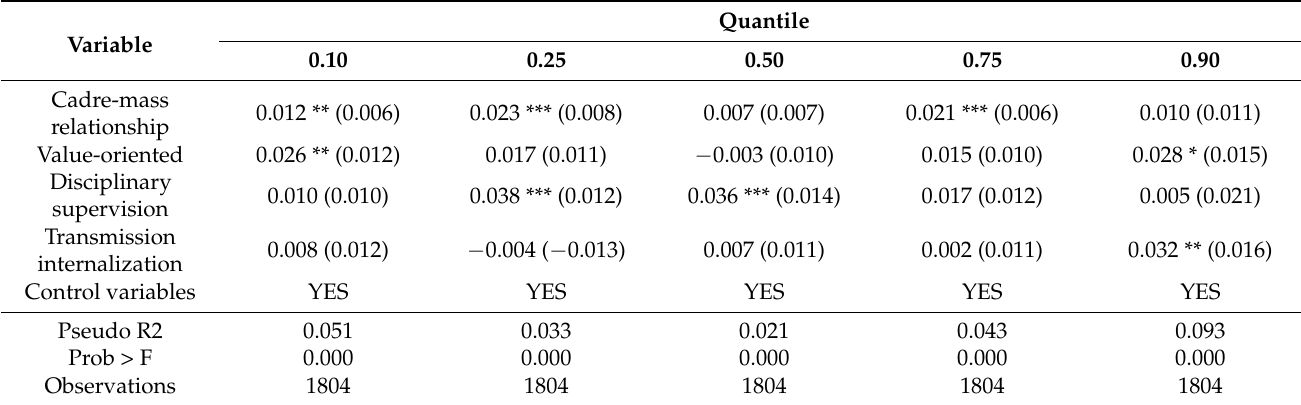
Table 5. Results of quantile regression.